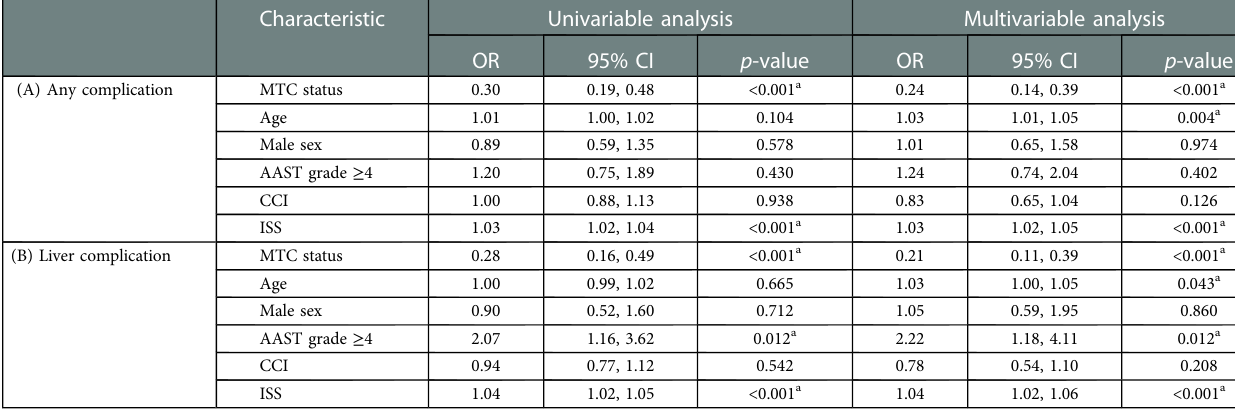
TABLE 3 Odds ratio of having (a) any complications and (b) liver complications according to MTC status adjusted for potentially confounding patient and injury characteristics. Characteristic Univariable analysis Multivariable